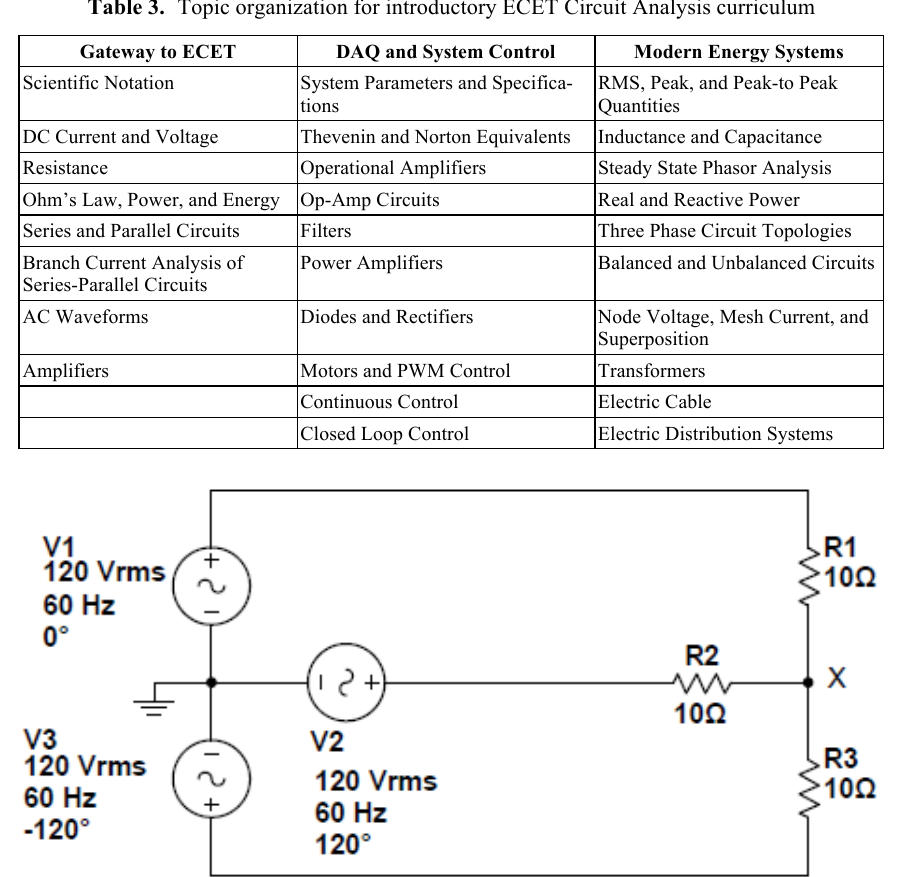
Fig. 1. Three phase circuit for instruction on node voltage, mesh current, and superposition